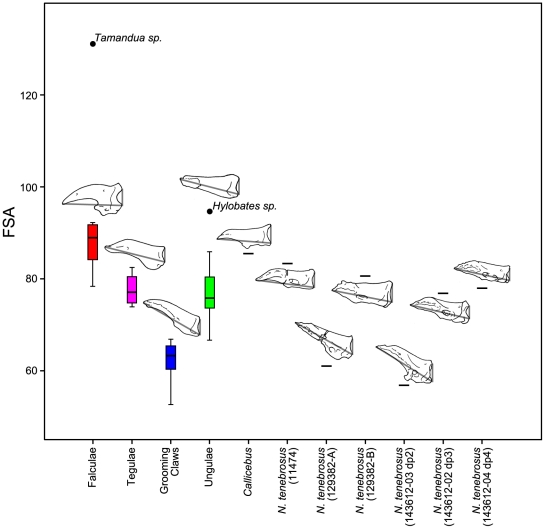
Boxplot of angle formed between distal phalanx proximal articular facet and shaft.Facet-Shaft Angle (FSA, the angle between the two segments) is demonstrated using illustrations of specimens scaled to the same length and oriented such that the superior and inferior margins of the articular facet are within the same plane. The median specimen from each extant group is illustrated: Suricata suricatta represents the falculae group; Callithrix sp., tegulae; Hapalemur griseus, grooming claws; and Galago senegalensis, ungulae. See Materials and Methods for measurement description.